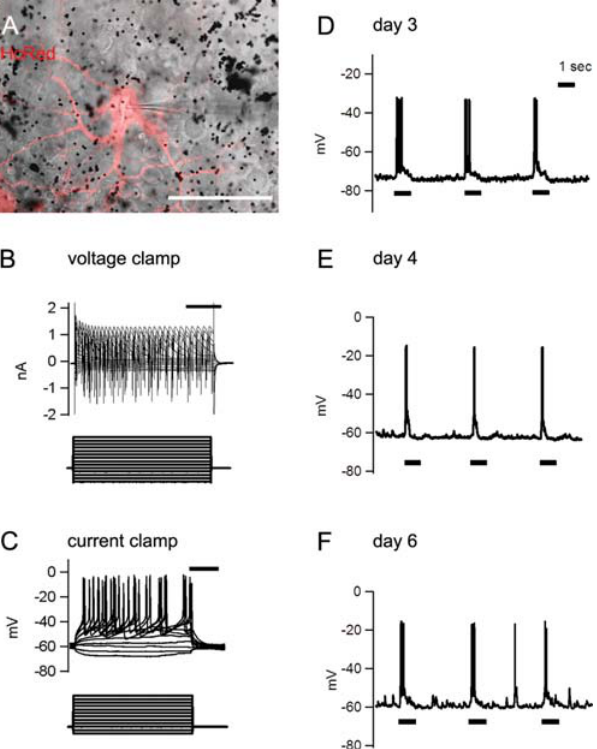
Figure 3. Patch-clamp recordings and light responses from ganglion cells in the incubated retina. ( A ) HcRed-transfected ON-type retinal ganglion cells after 3 day incubation. The patch-clamp pipette is seen (its light responses shown in C). Black dots are unincorporated gold particles. Scale bar, 50 m m. ( B ) An example of voltage clamp and current clamp recordings after 6 day incubation. All of recorded ganglion cells (n=30) generated action potentials in response to current injection under current clamp configuration. In the voltage clamp, the cells were voltage-clamped at 2 77 mV and then command pulses were applied from 2 117 mV to 13 mV, in 10 mV steps, for 200 msec. In the current clamp, command pulses were applied from 2 40 pA to + 180 pA, in 20 pA steps, for 200 msec. Scale bars are 50 msec. ( C–E ) light responses of ganglion cells from 3 day (the cell shown in A), 4 day, and 6 day- incubated retina, respectively, recorded under current clamp.